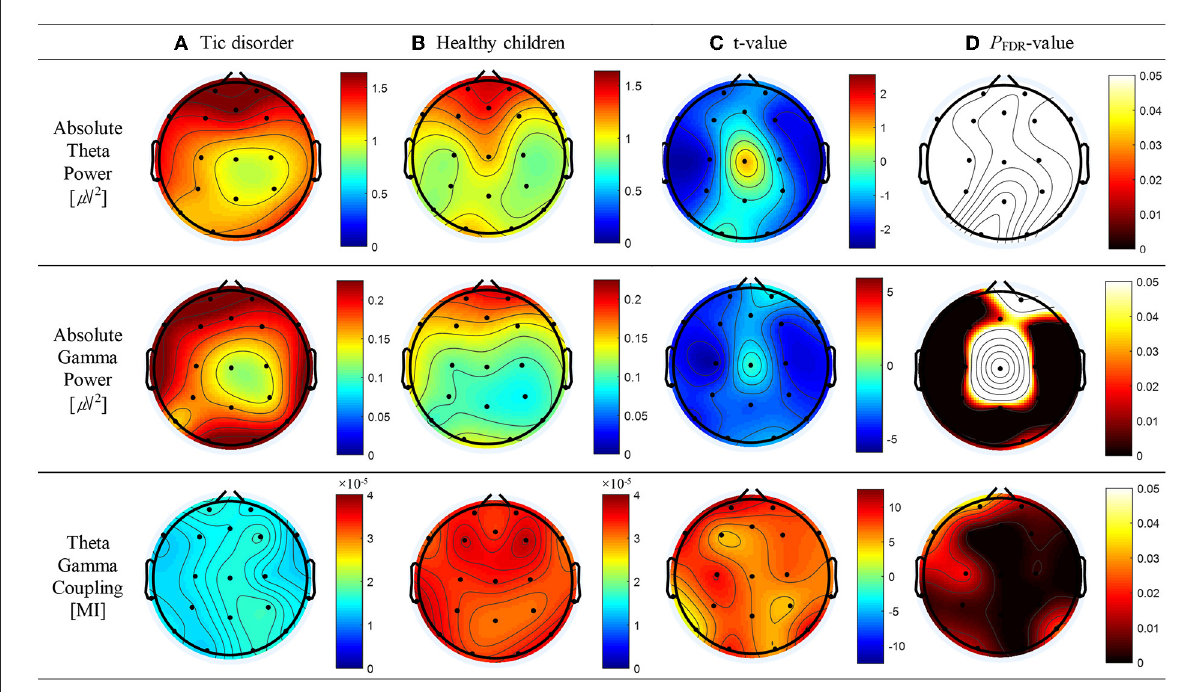
FIGURE1 Topographic maps of absolute theta power, absolute gamma power, and theta–gamma coupling (TGC). (A) Absolute theta power, absolute gamma power, and TGC in patients with tic disorder. (B) Absolute theta power, absolute gamma power, and TGC in healthy children. (C) Topographical distribution of the t -value. (D) Topographical distribution of the corresponding false discovery rate–corrected p -value.